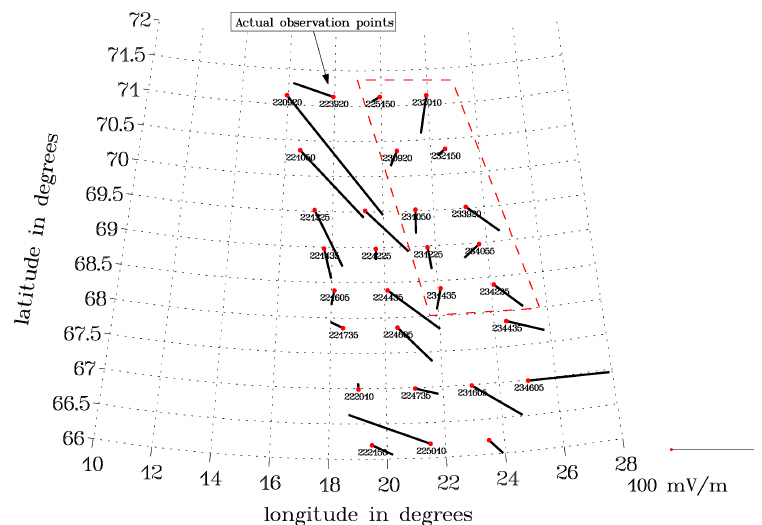
Fig. 11. Electric field measured by EISCAT for four consecutive scans from north to south between 22:00–00:00 UT (two vectors have been deleted for data quality reasons). Data of the scan 22:30–23:00 UT are shown at the actual observation points, data of earlier scans are shifted westward, of later scans eastward. The area enclosed by the red dashed line marks the spatio-temporal domain of the substorm intensification and recovery